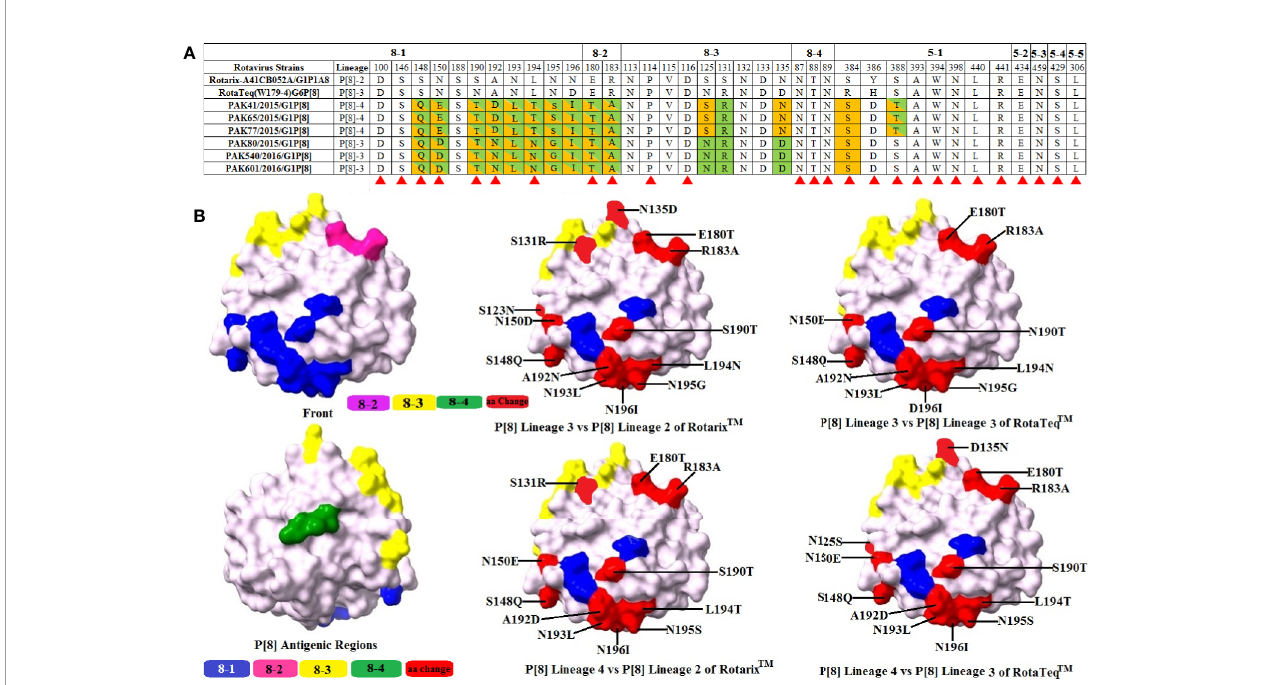
FIGURE 5 | Alignment of the antigenic epitopes of VP4-P[8] of the Pakistani group A rotavirus (RVAs) with those of Rotarix ™ and RotaTeq ™ vaccines. (A) The whole antigenic region is divided into four epitopes 8-1, 8-2, 8-3, and 8-4 for VP8* and fi ve epitopes for VP5*. Amino acid residues shading in green and orange are those different from Rotarix ™ and RotaTeq ™ , respectively, amino acid residues highlighting in green/orange colour are those different from both Rotarix ™ and RotaTeq ™ and amino acid residues believed to induce escape from the mAbs neutralization are marked with red triangle (41). (B) Representation of surface exposed amino acid residues of VP4 core VP8* core (PDB 1KQR). Antigenic epitopes 8-1, 8-2, 8-3, and 8-4 are represented by blue, pink, yellow, and green colours, respectively. Red colour shows surface exposed residues which differ between our P[8] strains and vaccine